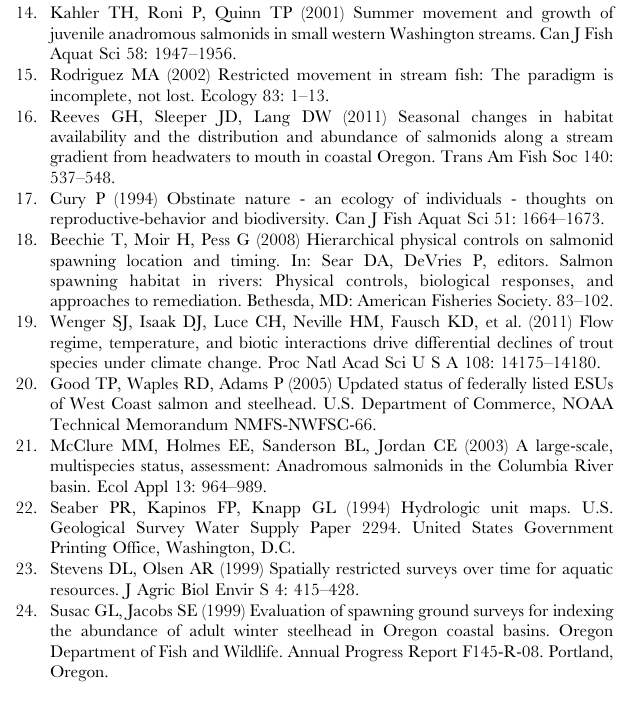
Figure S1 Empirical variogram [ 1 ] of residuals from a hurdle count regression model predicting the distribu- tion and abundance of steelhead redds in the John Day River basin, Oregon, USA. The variogram depicts the semivariance (y-axis) as a function of separation distance (x-axis) for 209 sites with 2.5 th and 97.5 th percentiles from 5000 permutations (dashed lines). Figure S2 Frequency distribution of maximum steel- head redd counts in the John Day River basin, Oregon, USA collected from